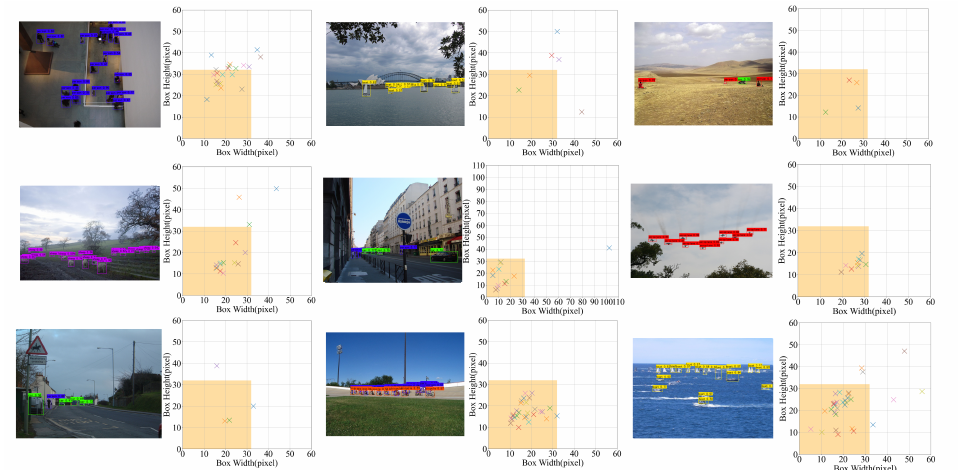
Figure 12. Visualization of small object detections. Each group’s right sub-image shows the left image’s object box’s size dispersion. The threshold range of the small object box is represented by the yellow